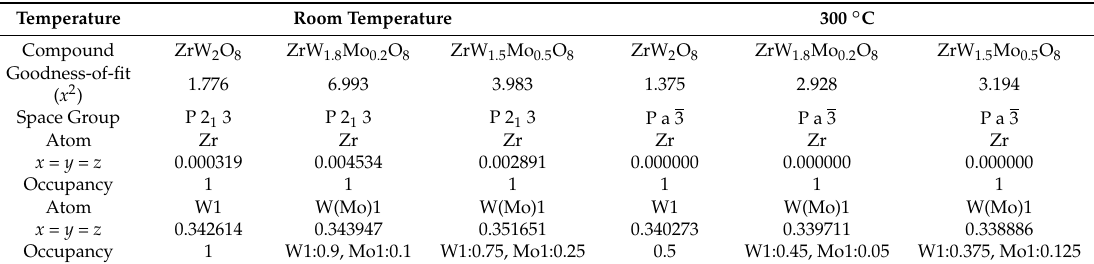
Table 3. Rietveld refinement of atomic coordinates and occupancy of ZrW 2 − x Mo x O 8